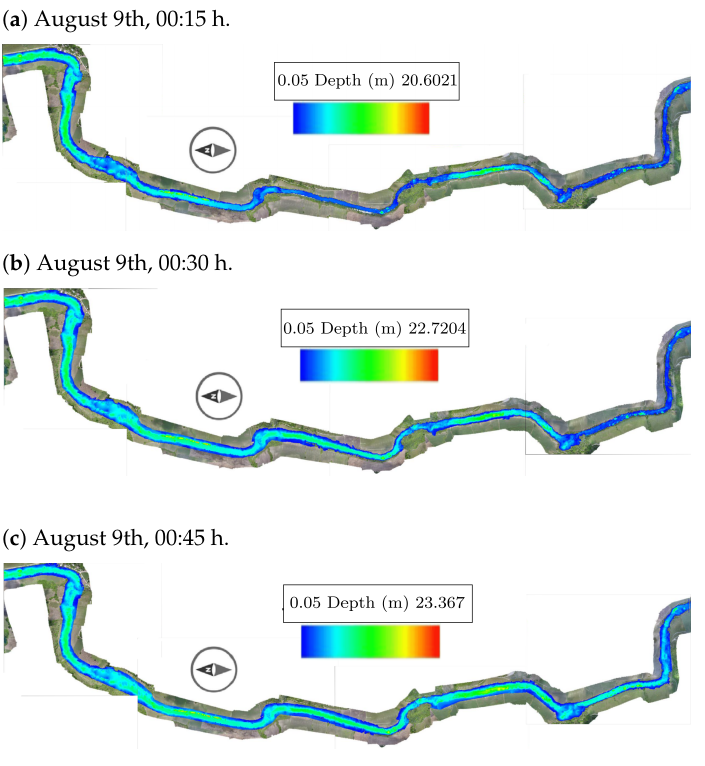
Figure 17. Depths for scenario